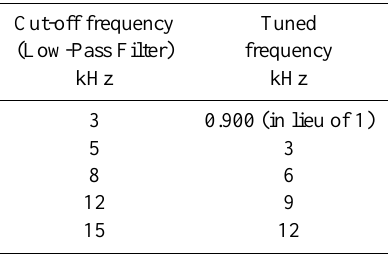
Table 1. Cut-off frequency of low-pass filter and corresponding tuned frequency.